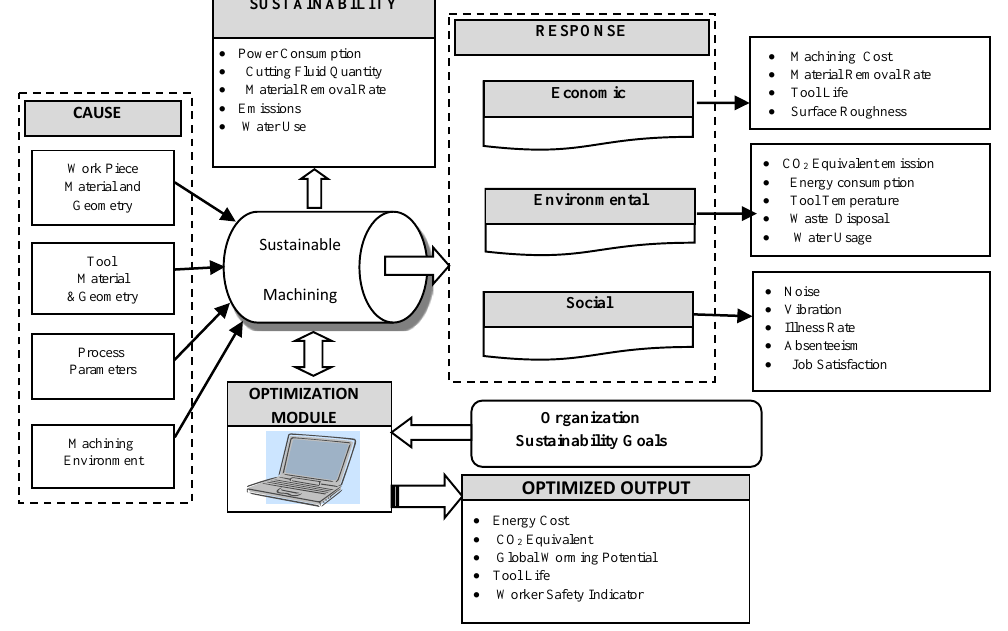
Fig. 2. Sustainability assessment